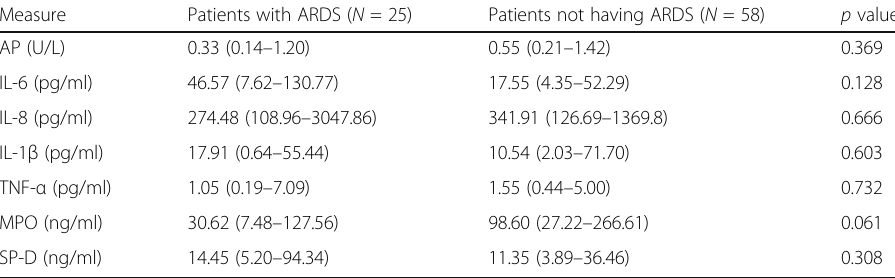
Table 2 AP activity and markers of inflammation and lung injury in BALF, corrected for dilution factor Measure Patients with ARDS ( N = 25) Patients not having ARDS ( N = 58) p value AP (U/L) 0.33 (0.14 –